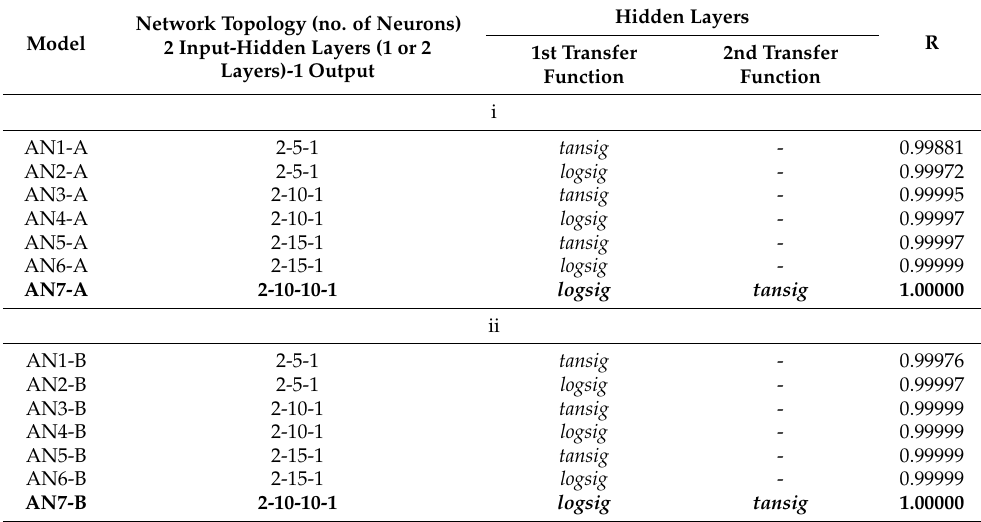
Table 5. Comparison between different ANN structures for the two sets: (i) mixtures of PS and PP, (ii) mixtures of PS, LDPE, and PP. Network Topology (no. of Neurons) Model 2 Input-Hidden Layers (1 or 2 Layers)-1 Output